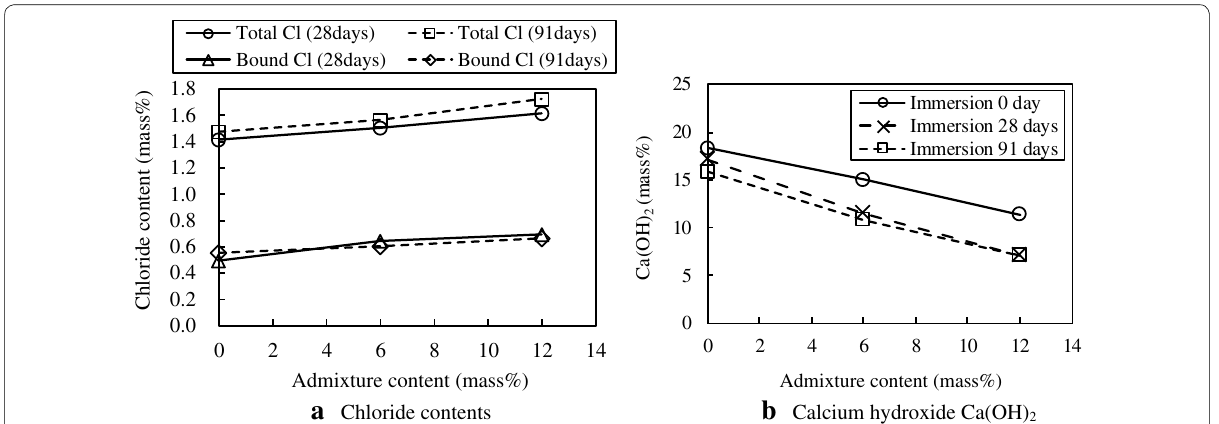
Fig. 8 Chloride and calcium hydroxide contents varied by the admixture content: ( a ) chloride contents; ( b ) calcium hydroxide Ca(OH) 2